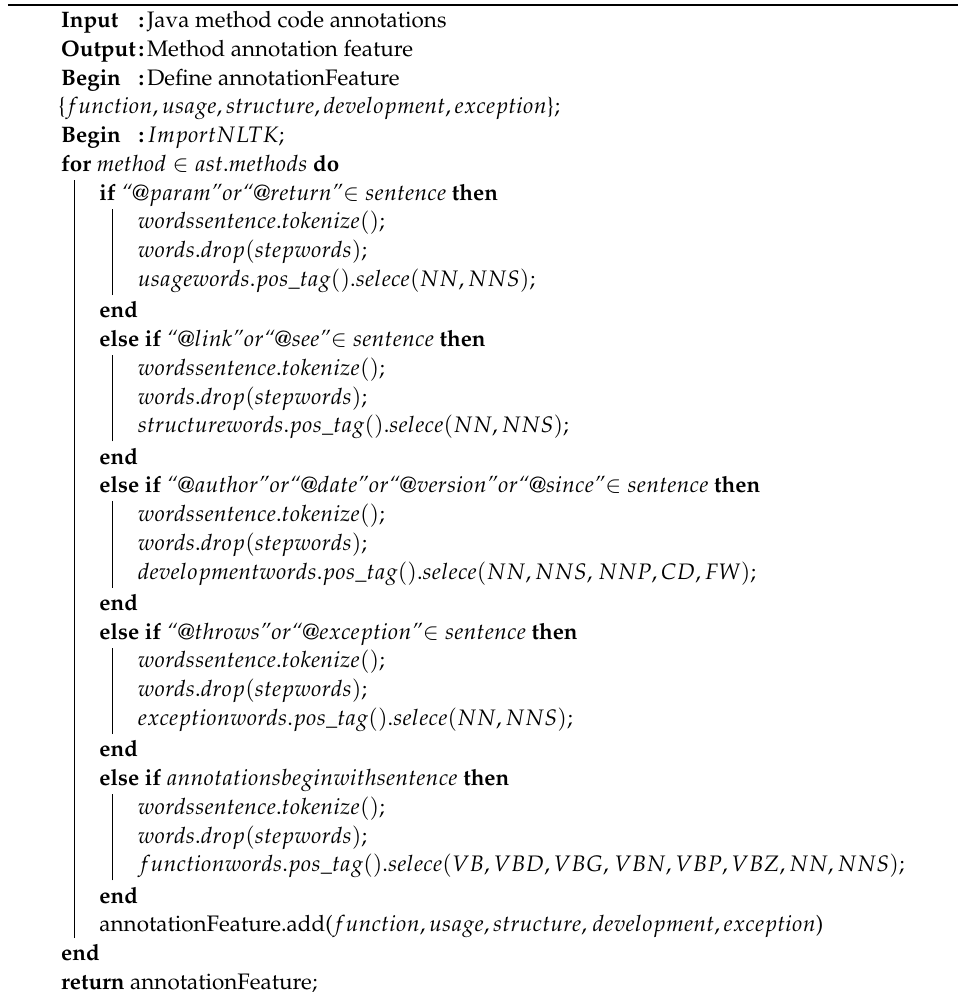
Algorithm 2: Annotation feature extraction